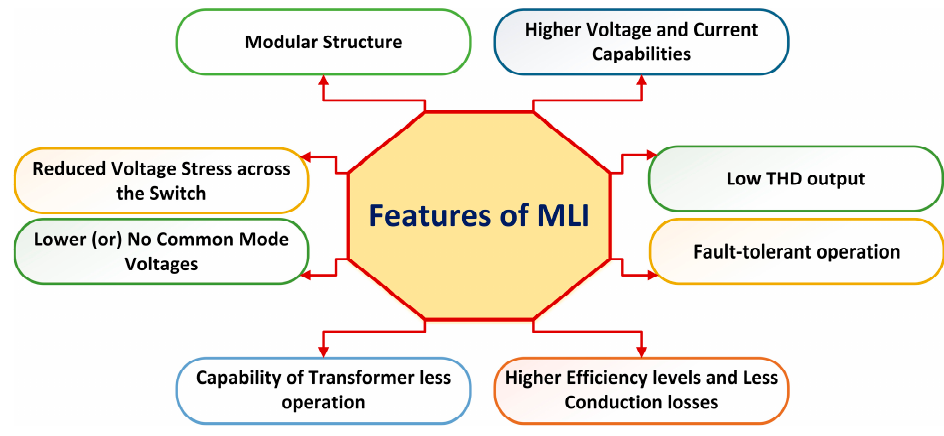
Figure 9. Features of MLIs.